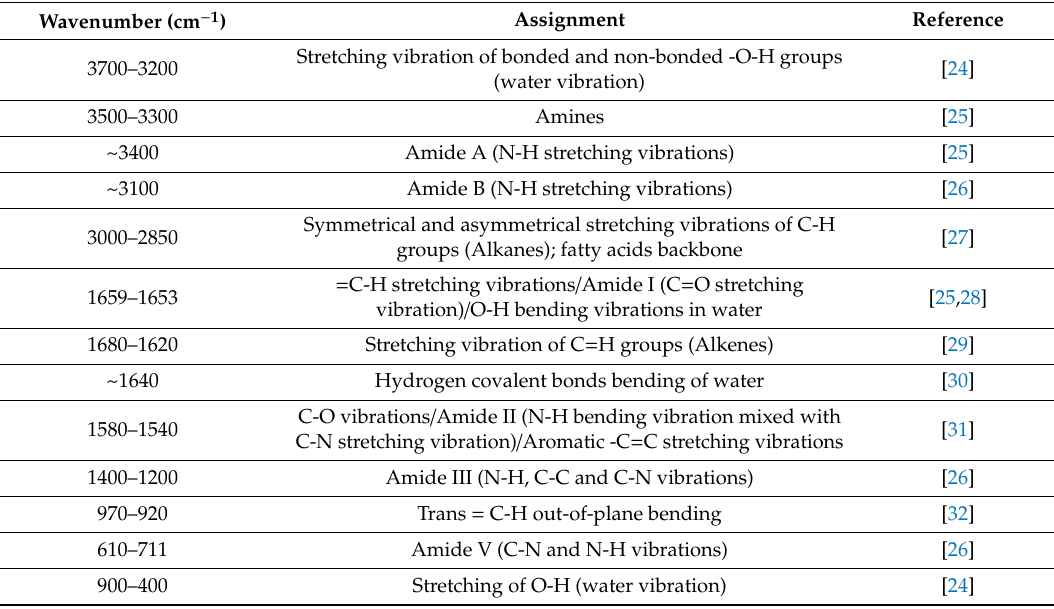
Figure 3. ( a ) ATR MIR spectra of P_OX (protein oxidation) samples (108 analyses) and expanded areas of interest: ( b ) 2750–3100 cm − 1 ; ( c ) 950–1500 cm − 1 . Table 2. Compilation of principal wavenumbers associated to functional groups.